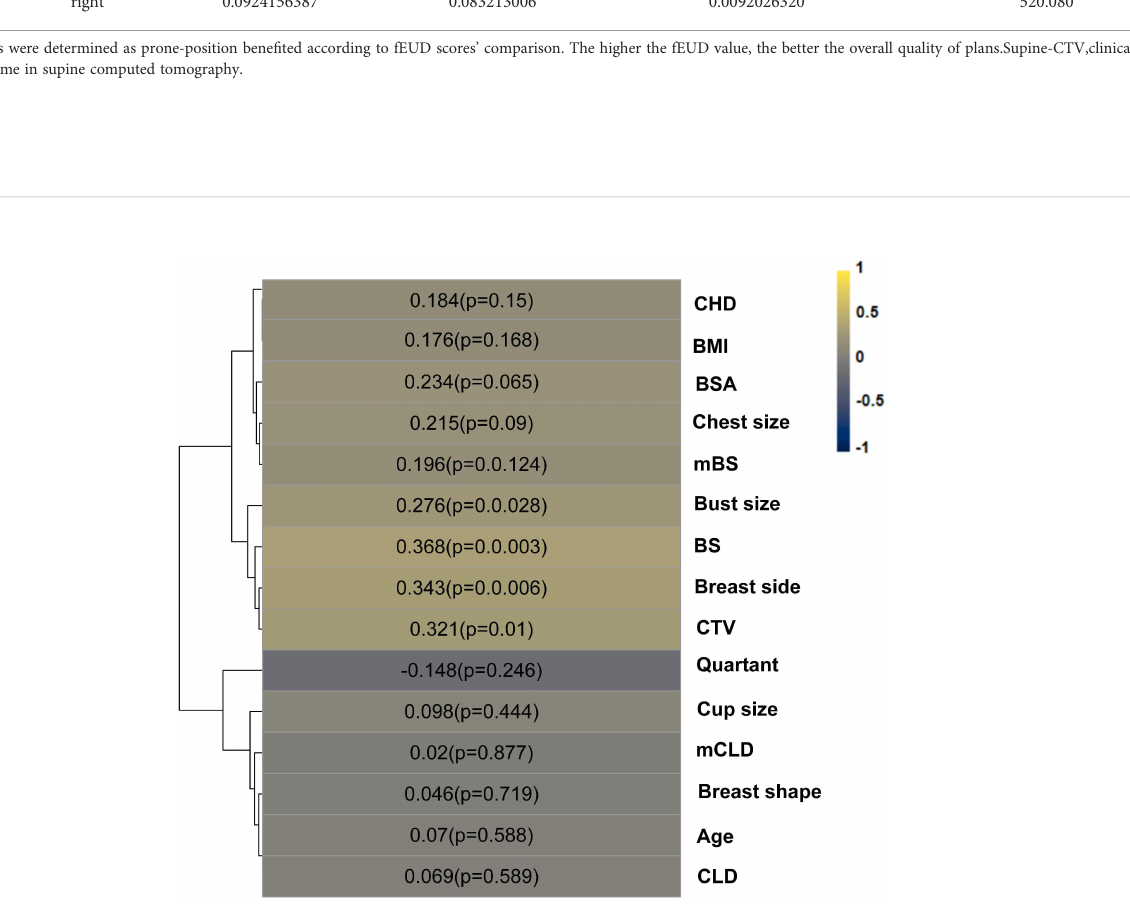
FIGURE 6 Color map of rho between “ △ fEUD ” and somatotype parameters. “ △ fEUD ” , whether the prone plan is better than the supine, yes=1, no=0.